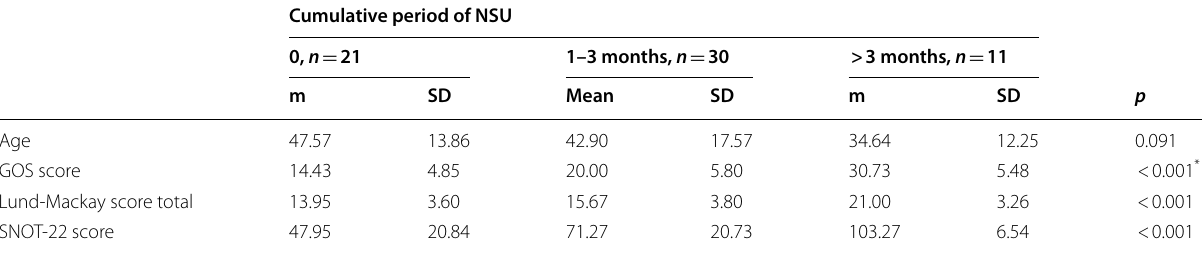
Table 3 Mean and standard (m SD) deviations of outcome parameters according to cumulative period of nasal steroid use (NSU) +